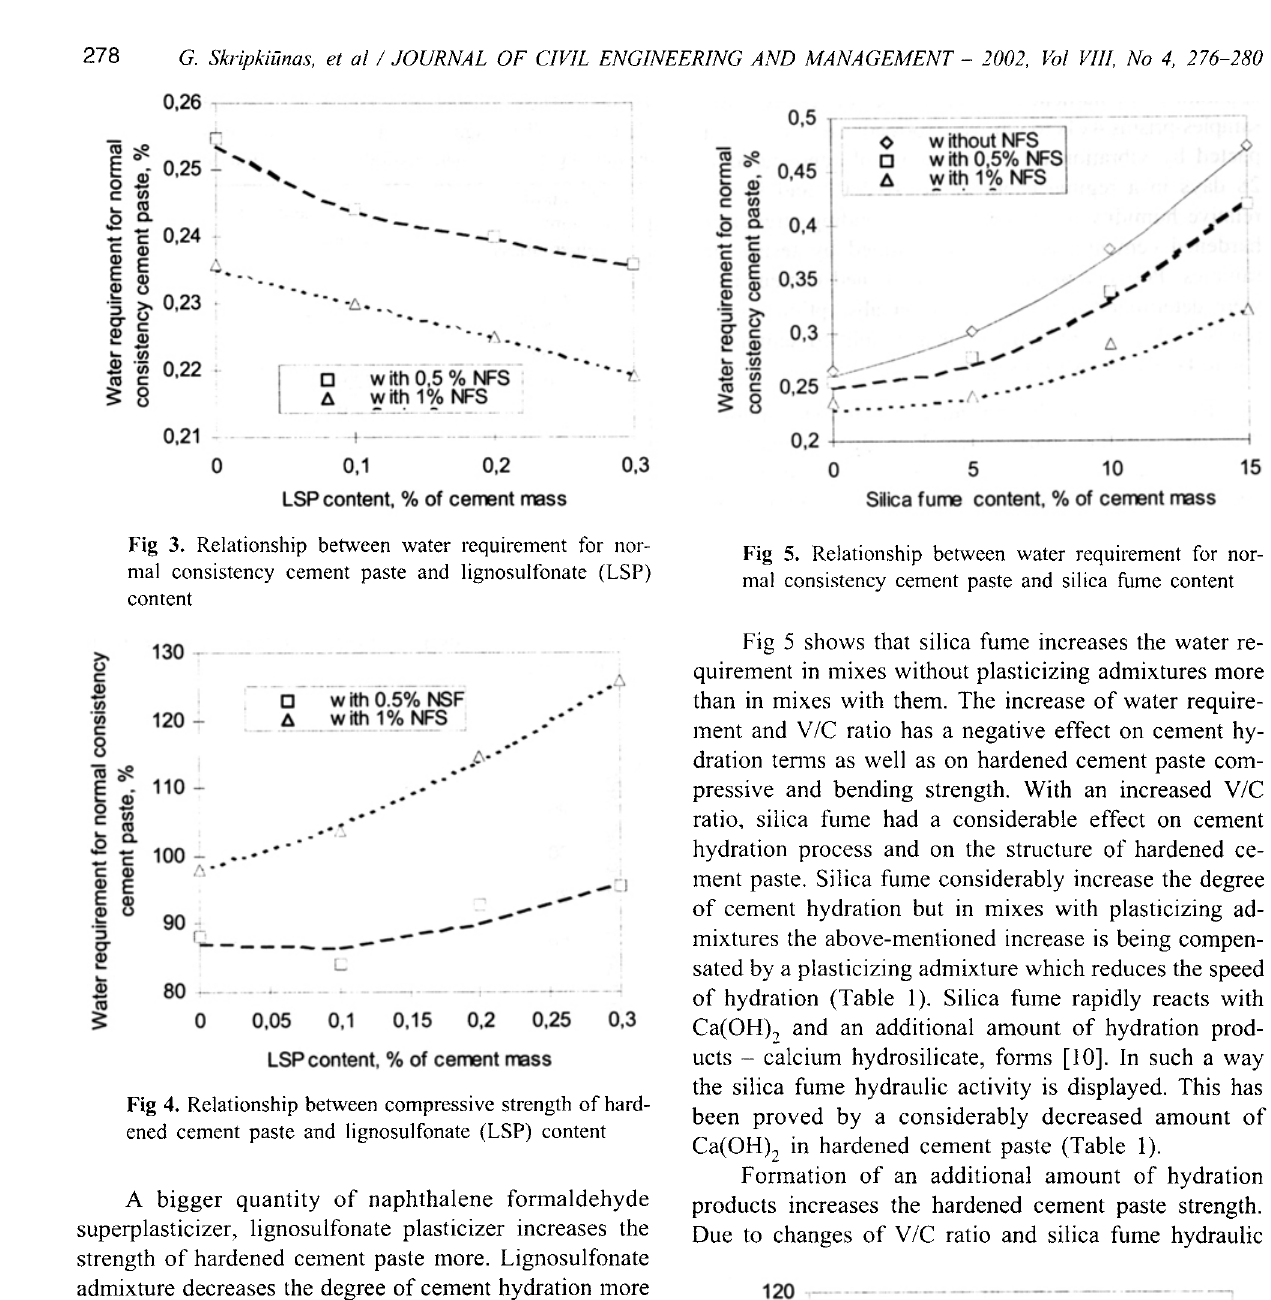
Fig 3. Relationship between water requirement for nor mal consistency cement paste and lignosulfonate (LSP)